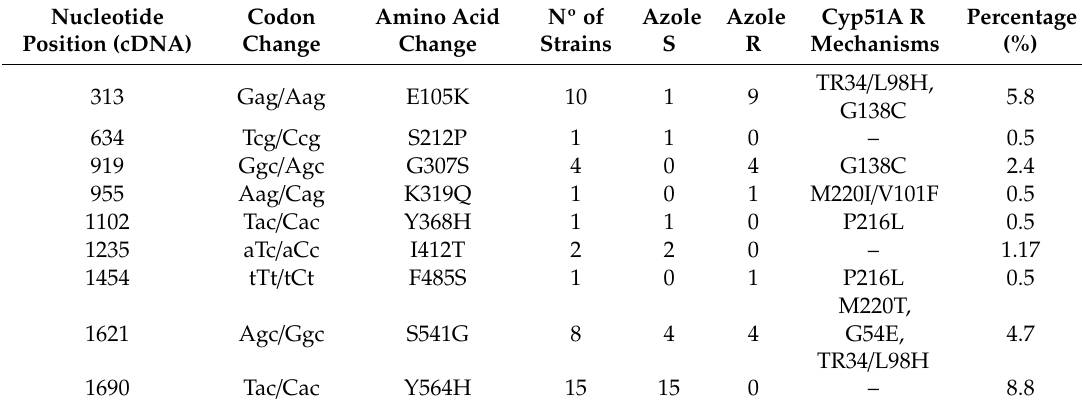
Table 5. Analysis of the Hmg1 Amino Acid Substitutions Found in Our Set of 170 A. Fumigatus Clinical